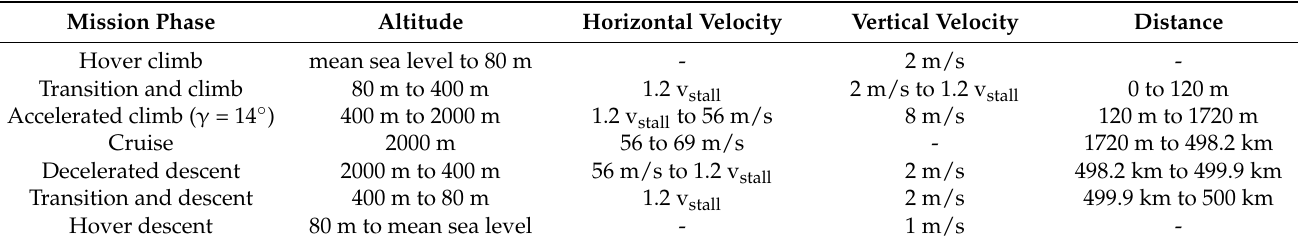
Table 2. Mission phase parameters.